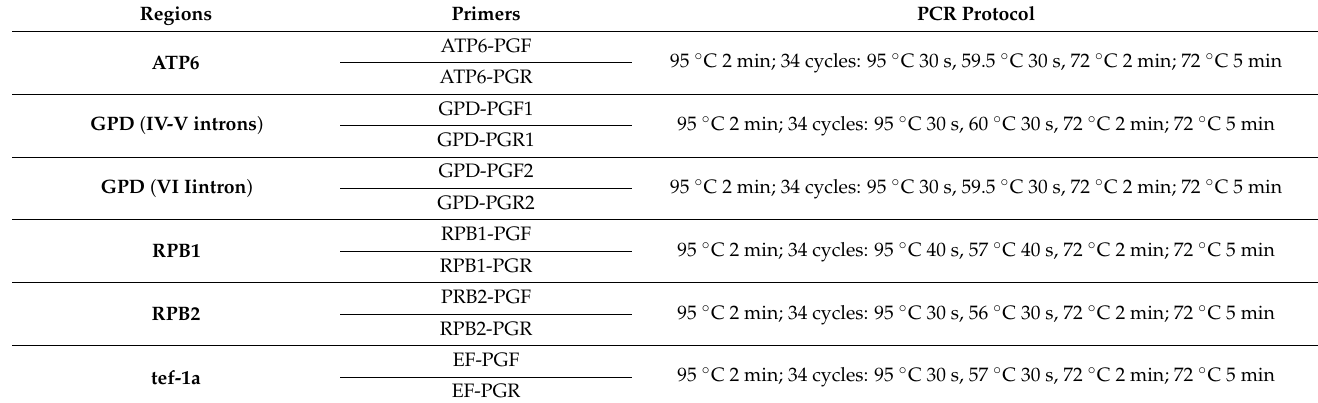
Table 3. PCR protocols for the use of primers designed in this study.